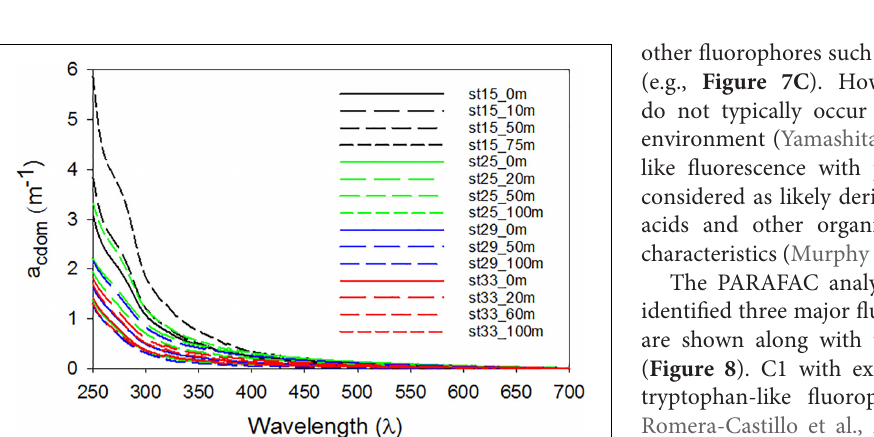
FIGURE 4 | Upper water column DOC and CDOM. Vertical profiles of (A) DOC ( µ M C), (B) CDOM absorption coefficients a cdom 325 (m − 1 ) and (C) spectral slope S or S